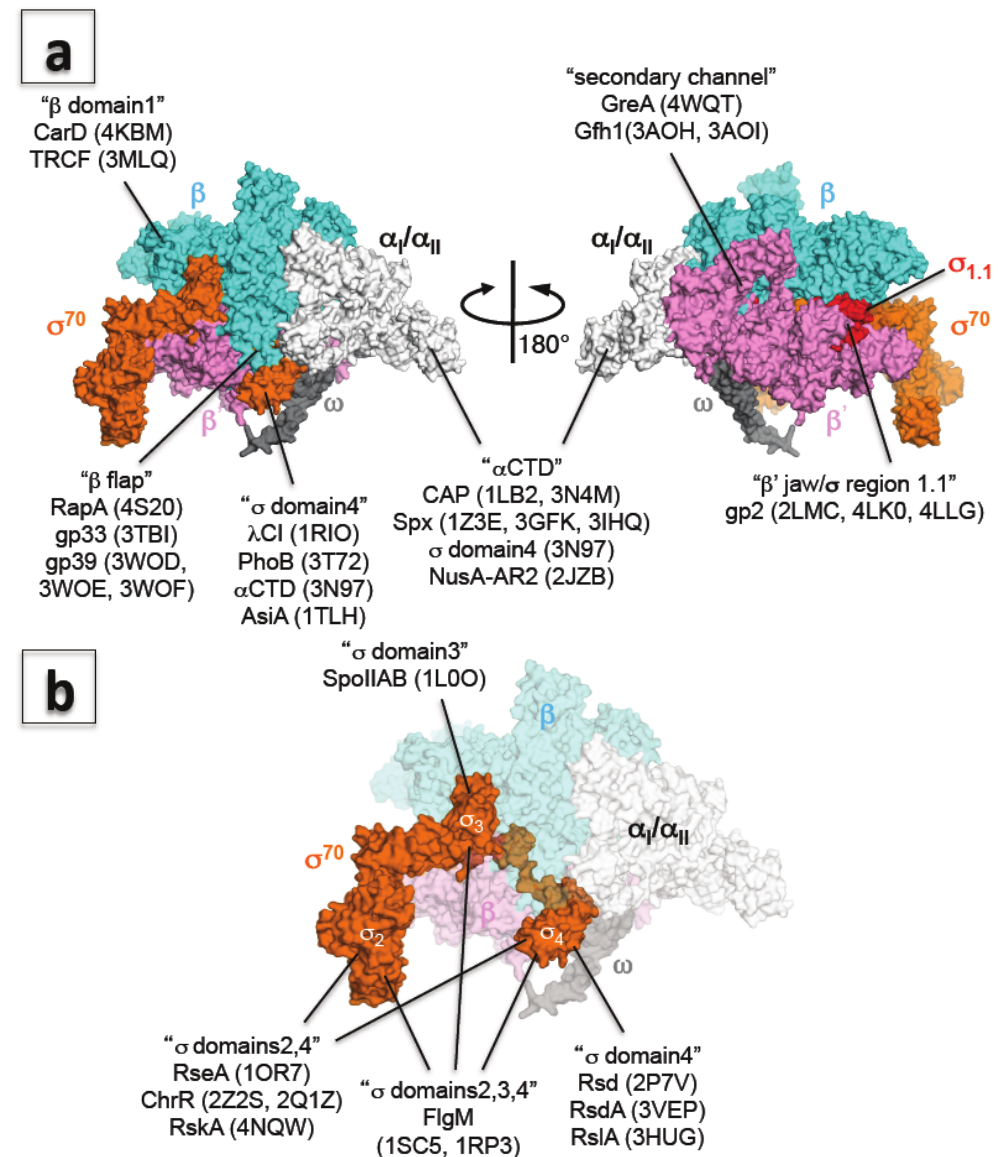
Figure 2. ( a ) Three-dimensional representation of the interaction between RNAP and transcription factors. The E. coli RNAP holoenzyme is shown as a molecular surface representation ((cid:3) subunits: white; (cid:4) subunit: cyan; (cid:4)’ subunit: pink; (cid:5) subunit: gray; (cid:2) 70 : orange; (cid:2) region 1.1: red). Transcription factors binding sites are indicated in double quotation marks and PDB codes of structures are shown in brackets; ( b ) Three-dimensional representation of the interaction between (cid:2) and anti-(cid:2) factors. E. coli RNAP holoenzyme is shown as a molecular surface representation, and only the core enzyme is partially transparent ((cid:3) subunits: white; (cid:4) subunit: cyan; (cid:4)’ subunit: pink; (cid:5) subunit: gray; (cid:2) 70 : orange). Targets of anti-(cid:2) factors are indicated in double quotation marks and PDB codes of structures are shown in